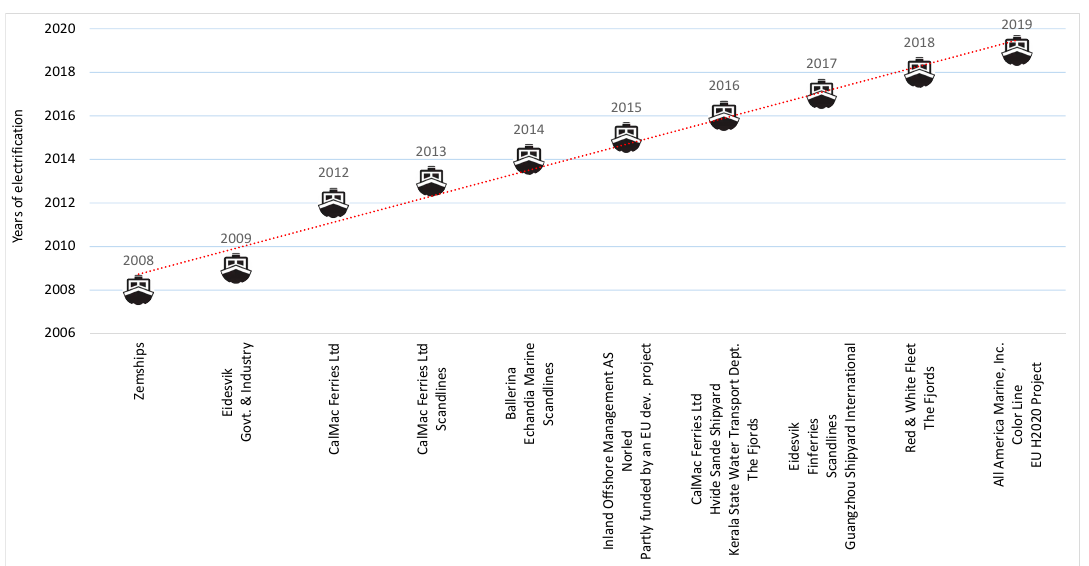
Figure 5. Companywide electrification of ships.